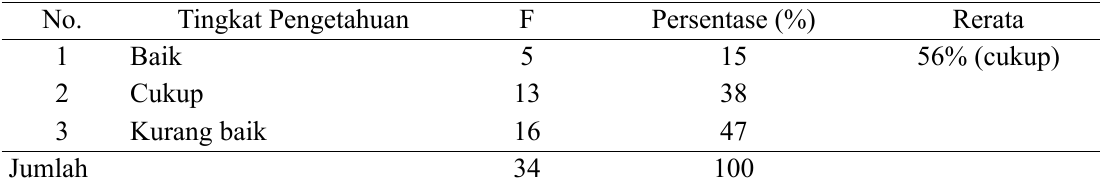
Tabel 4. Distribusi frekuensi pengetahuan (analisis) lansia tentang nutrisi di Posyandu lansia No.